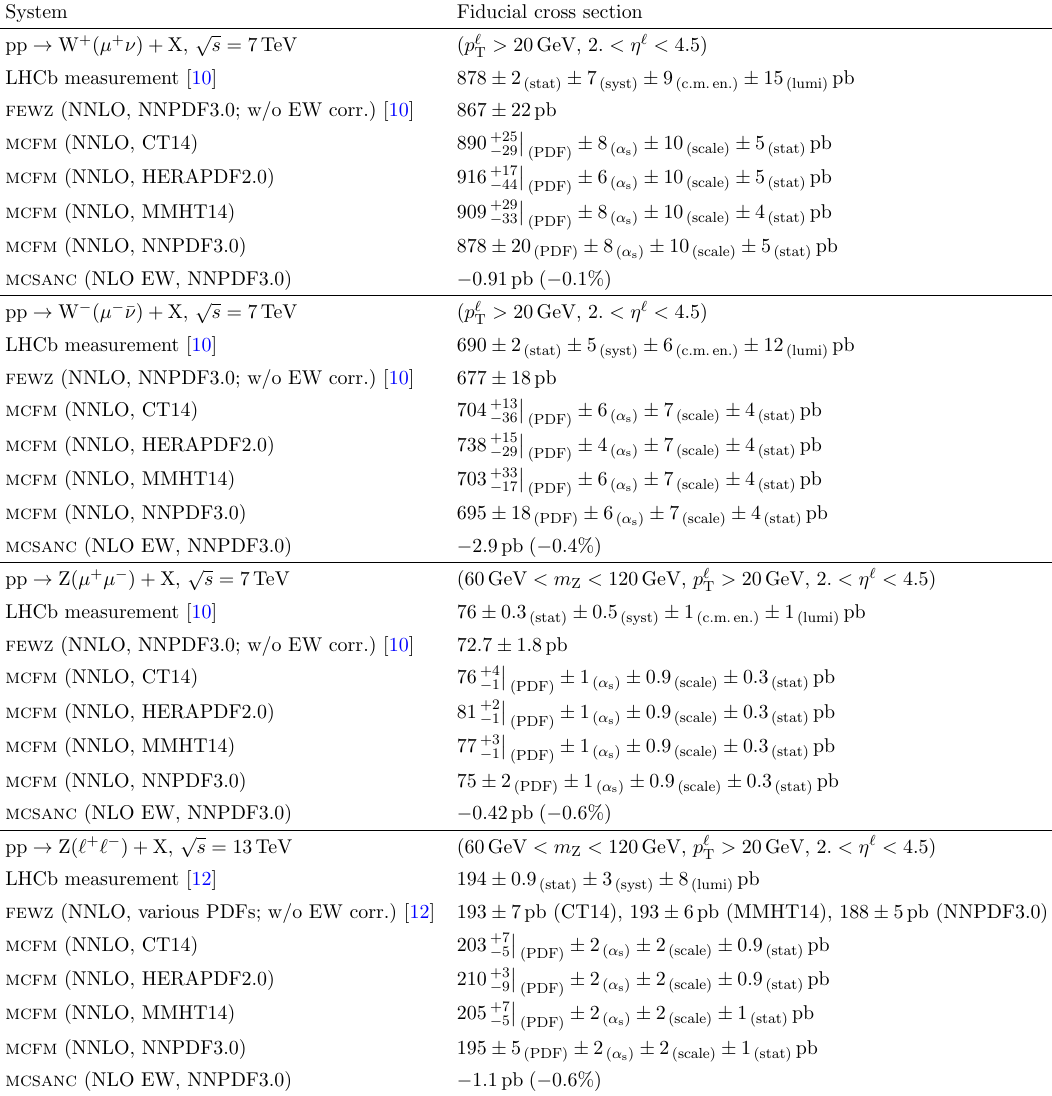
Table 7 . Comparison of the LHCb (cid:12)ducial cross sections for W + , W (cid:0) , and Z boson production p in pp collisions at s = 7 and 13 TeV to the NNLO pQCD results obtained with mcfm using the CT14, HERAPDF2.0, MMHT14, and NNPDF3.0 PDF sets, including NLO EW